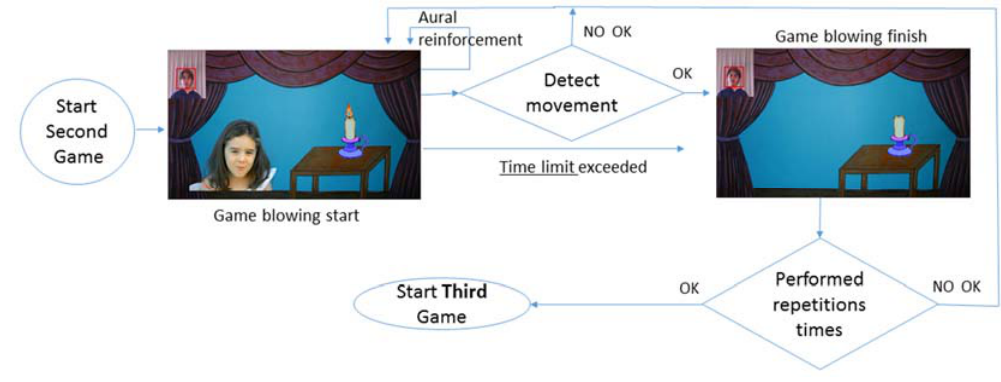
Figure 7. Activity diagram: blowing game.